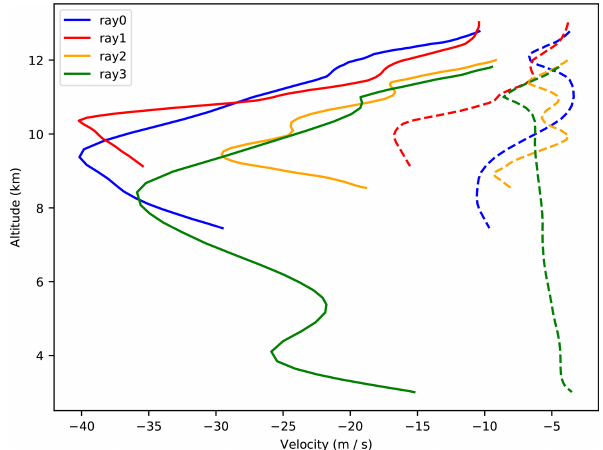
Figure 8. The horizontal phase velocity (dashed) and the back- ground wind (solid) along ray nos. 0 to 3. Where the phase veloc- ity and the wind speed approach one another a critical layer exists. Altitudes above the ray starting point (Table 1) represent the same starting conditions ray-traced